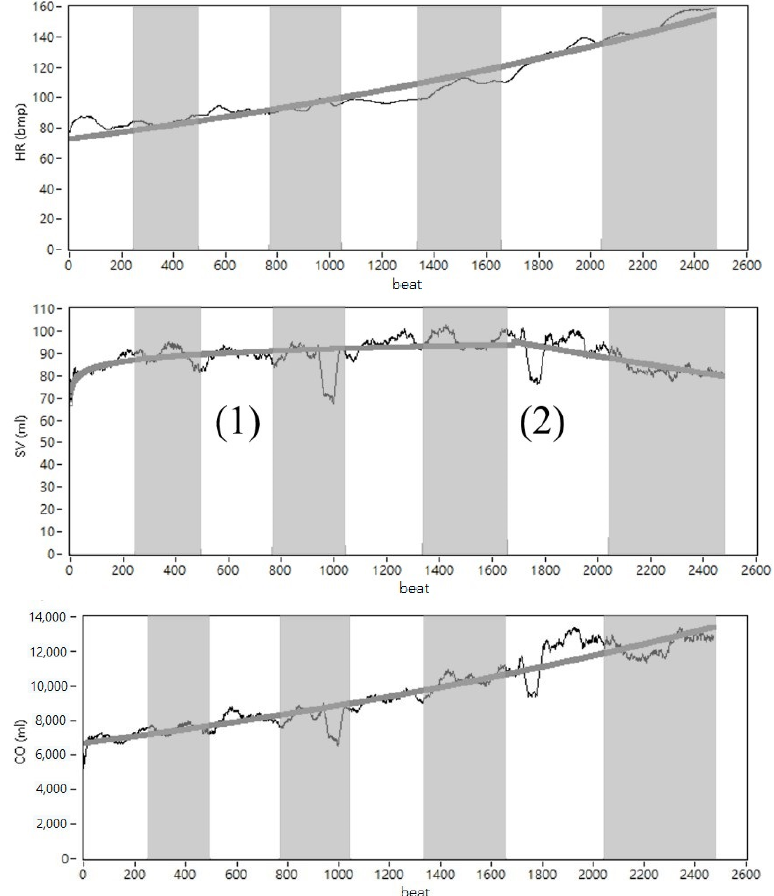
Figure 4. The beat-domain demonstration of HR ( upper ), SV ( middle ), and CO ( lower ) for patient #25. The white and gray blocks represent each sequence stage.